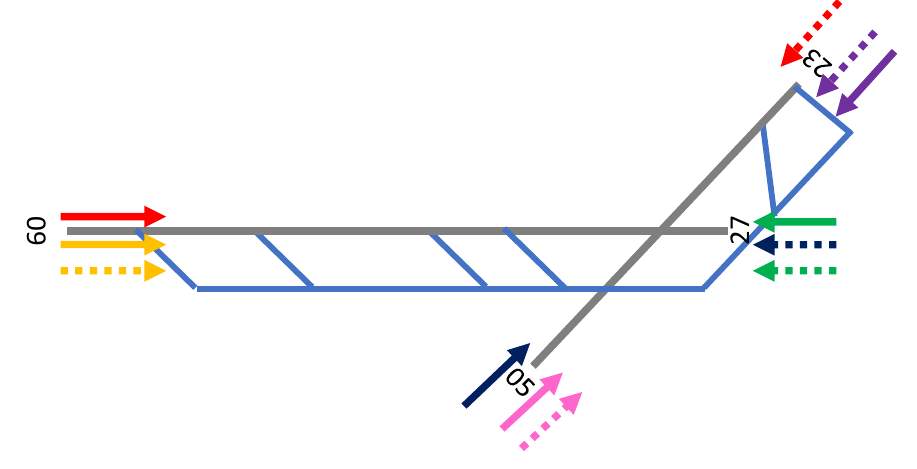
Figure 3. Operative airport layout .